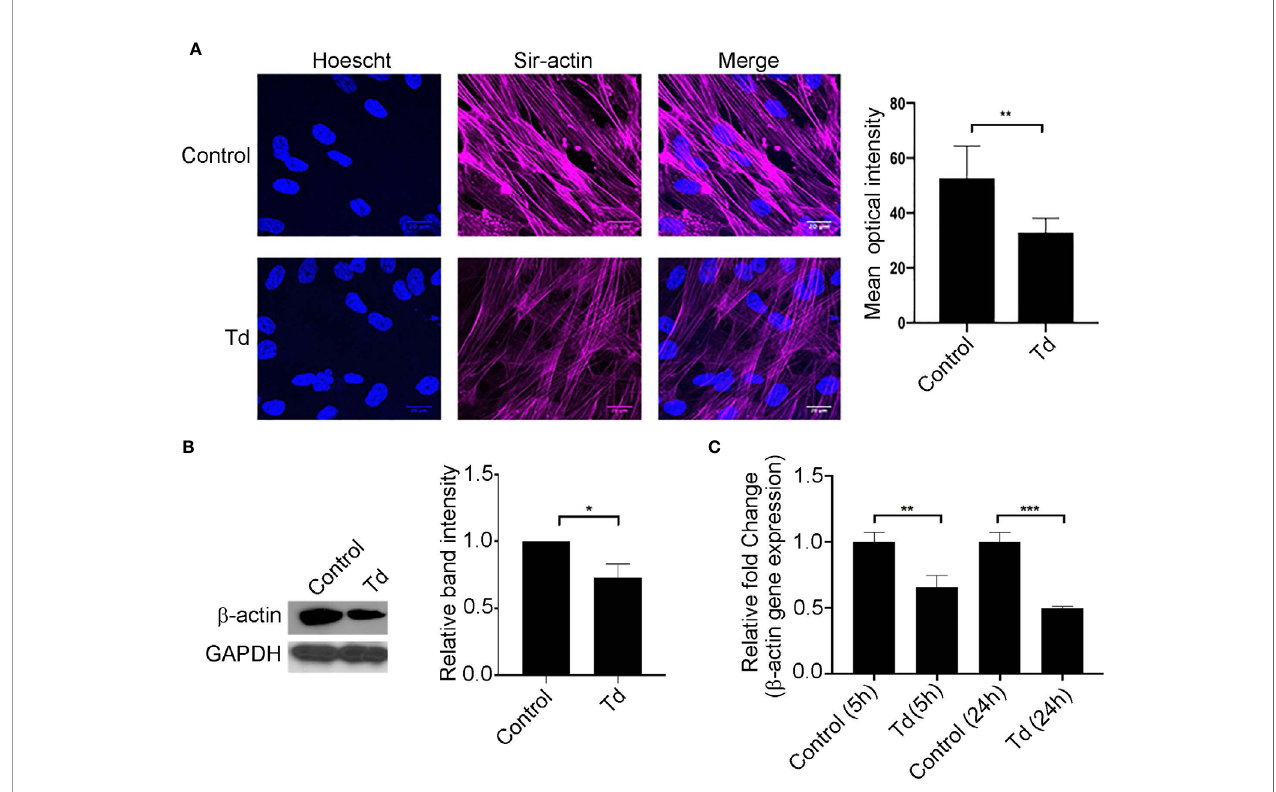
FIGURE 2 | T. denticola challenge decreases stress fi bers and b -actin protein monomer abundance in PDL cells. (A) ( Left ) PDL cells were unchallenged (control) or challenged with T. denticola (50 MOI) for 24 h and processed for immuno fl uorescent staining with Hoechst (nucleus, blue) and SiR-Actin probe, and imaged using confocal microscopy. ( Right ) Relative optical intensities were calculated from three independent experiments. (B) ( Left ) Representative immunoblot showing b -actin levels in PDL cells challenged with control medium or media containing T. denticola (50 MOI ) for 24 h. ( Right ), Densitometry analysis of three independent experiments was performed using ImageJ software, and the ratio of control samples to T. denticola was calculated. Data represent mean ± SD from three independent experiments. Data were compared using Student ’ s t-test. * = p<0.05; ** = p<0.01. (C) b -actin gene expression in PDL cells challenged with control medium or media containing T. denticola (50 MOI) for 5h or 24 h by RNA-Seq. The graph shows the fold changes on a log2 scale. Data were compared using Student ’ s t-test. ** = p<0.01; *** =